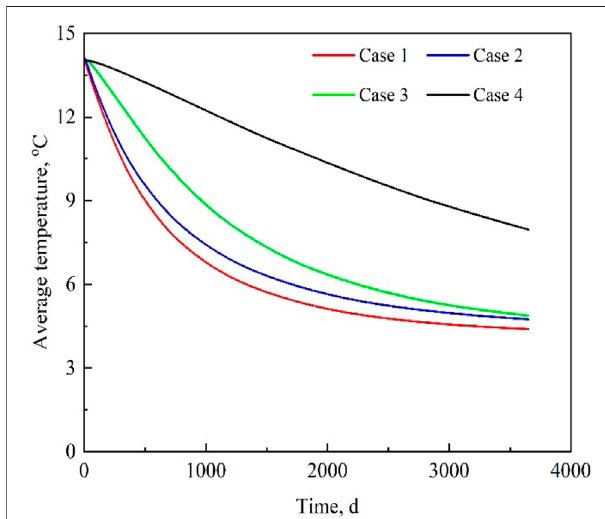
FIGURE 9 | Changes of average